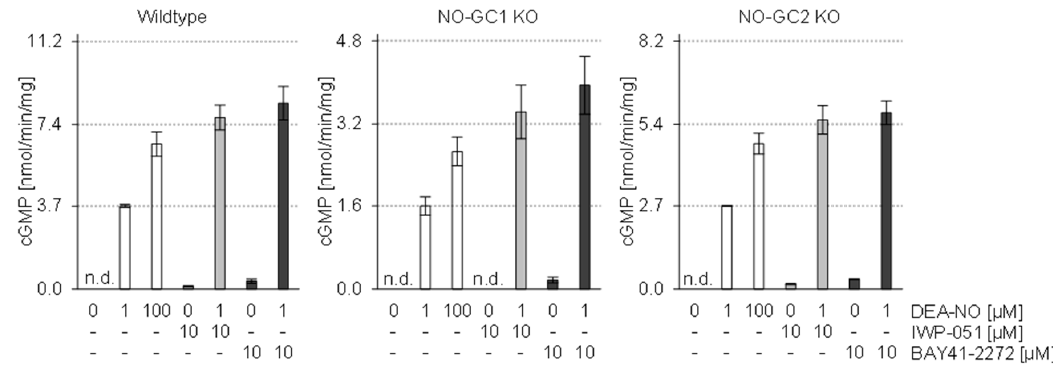
Figure 7. In vitro assays with brain homogenates do not show NO-GC1-specific activity of IWP-051. cGMP-forming activities of whole brain homogenates of wildtype, NO-GC1 KO and NO-GC2 KO mice were measured by [ 32 P] cGMP formation. Homogenates were incubated with the indicated concentrations of DEA/NO, IWP-051, and Bay 41-2272. As the knockout of either one of the NO-GC isoforms reduces the cGMP-forming activity, the panels have different ordinates. Open, light gray and dark gray bars show activities in the absence of NO-GC stimulators, in the presence of IWP-051 and in the presence of BAY41-2272, respectively. Data are shown as mean ± SD of three independent biological replicates analyzed for each genotype ( n = 9 mice in total); n.d., not detectable.